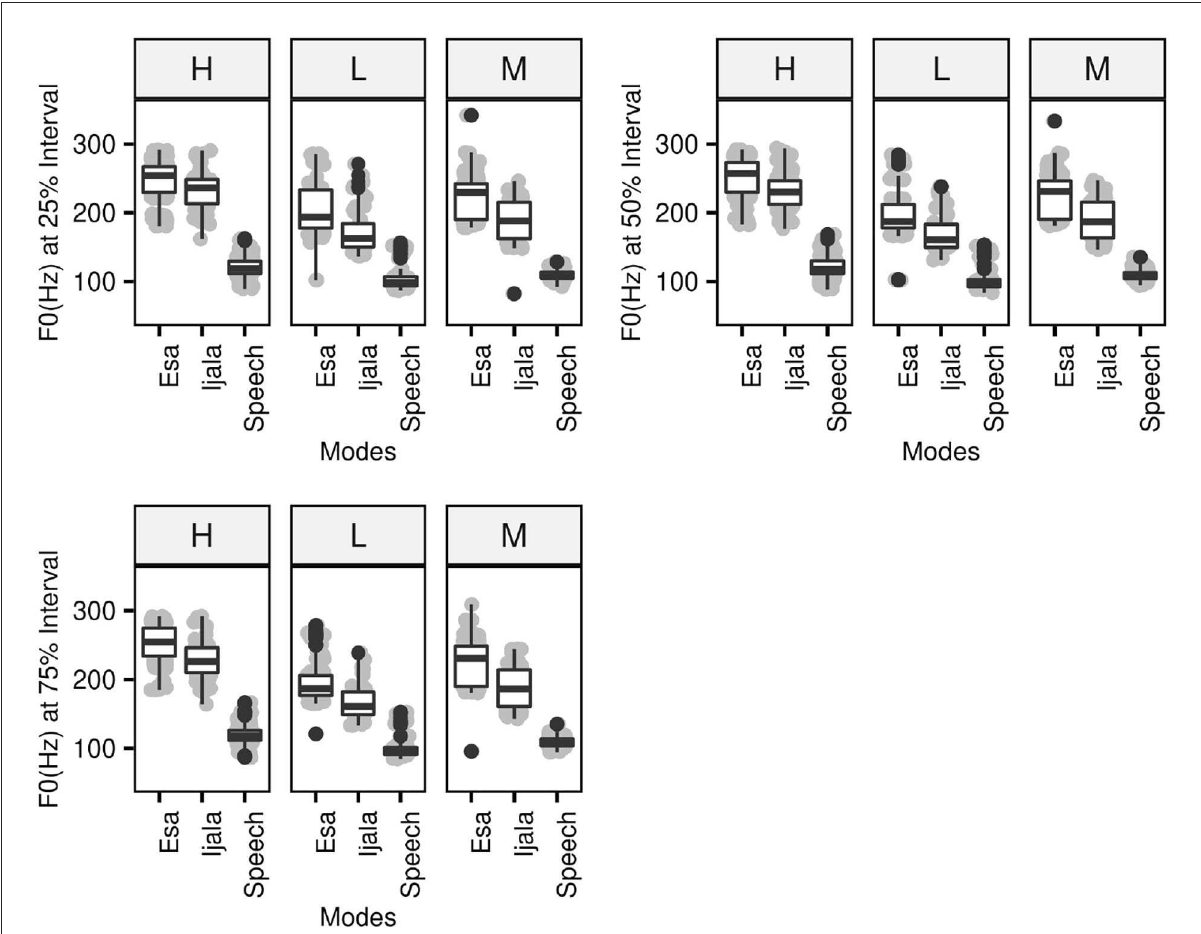
FIGURE3 F0(Hz) values of H, L, and M tones in speech and poetic modes at 25%, 50%, and 75%